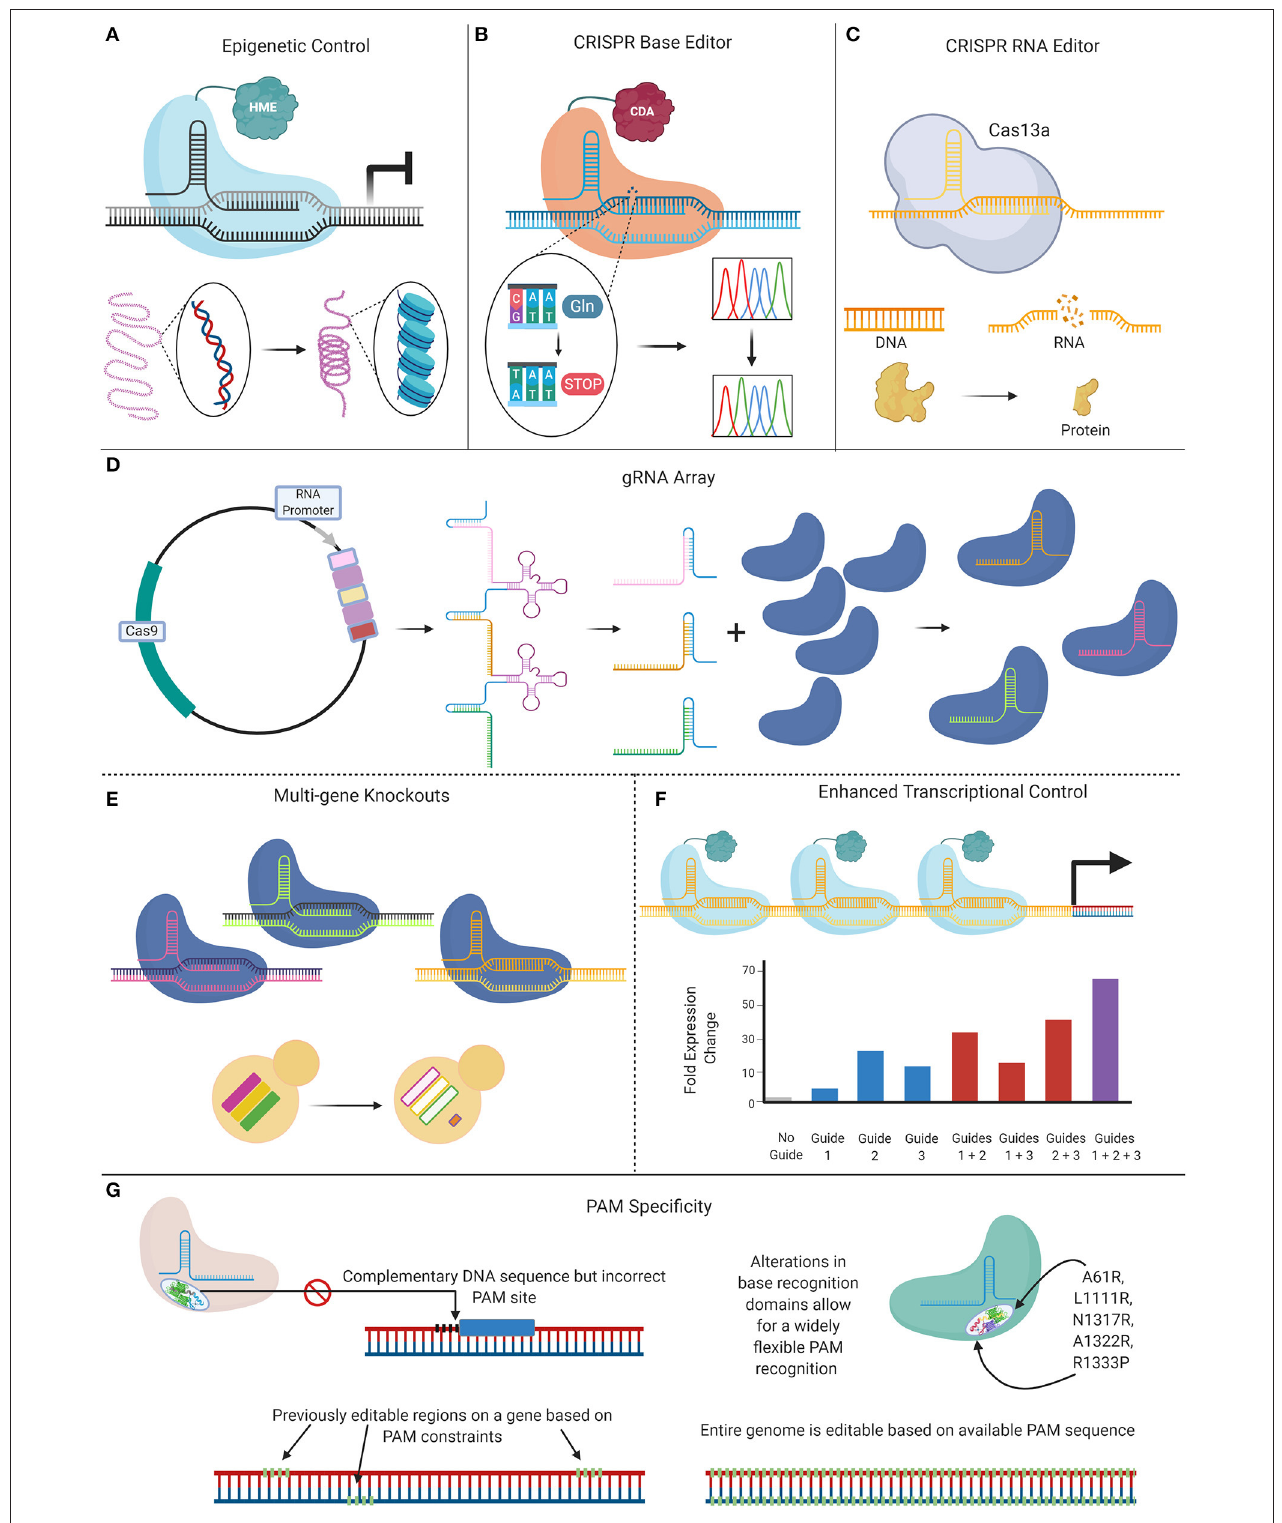
FIGURE 5 | Future applications for CRISPR in Candida . CRISPR systems continue to evolve, and these novel technologies may be applied to Candida species. (A) CRISPR-based epigenetic modification systems can be applied to Candida species, whereby dCas9 is fused to histone modifying enzymes (HMEs) that can influence chromatin structure, affecting DNA expression. (B) Another novel CRISPR application for Candida species are CRISPR base editors that have a nickase variant of